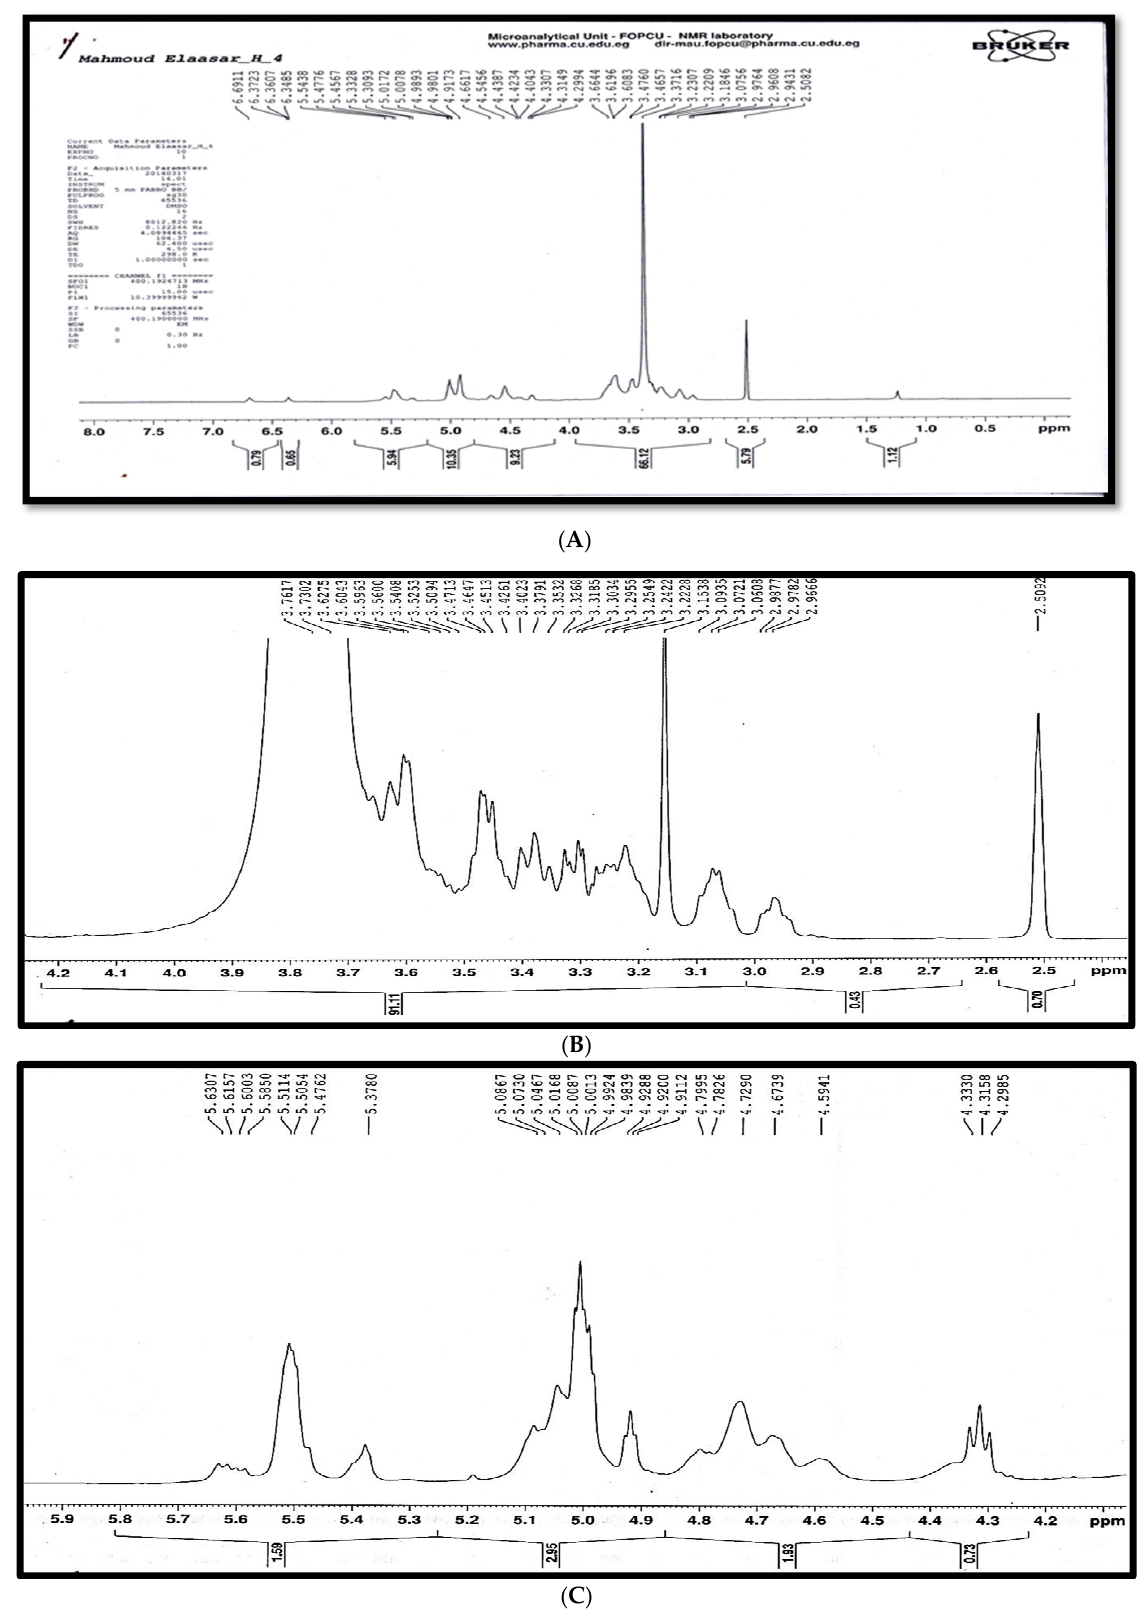
Figure 6. 1 H-NMR spectrum of the antibacterial agent (fraction 6), ( A ) Full spectrum, ( B ) Expansion of 1 H-NMR spectrum partially from 2.00 ppm to 4.00 ppm, ( C ) Expansion of 1 H-NMR spectrum partially from 4.20 ppm to 5.80 ppm.